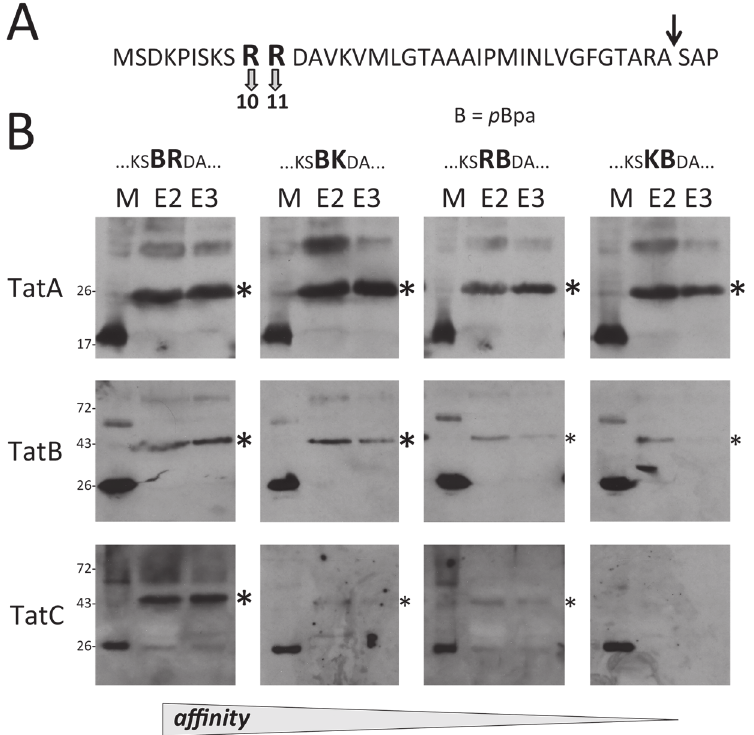
Fig 4. TatA does not recognize the RR motif. (A) Positions of arginines in the twin-arginine motif that were mutated for experiments shown under B). (B) Analyses of cross-links to Tat components with p Bpa (abbreviated “ B ” ) at indicated twin-arginine motif positions (expression system and [ p Bpa] as in Fig. 1). Additional R > K exchanges are indicated. A decrease of TatBC cross-link intensities relates to decreasing affinities as indicative for the twin-arginine motif recognition (indicated at the bottom) that is confined to TatBC.